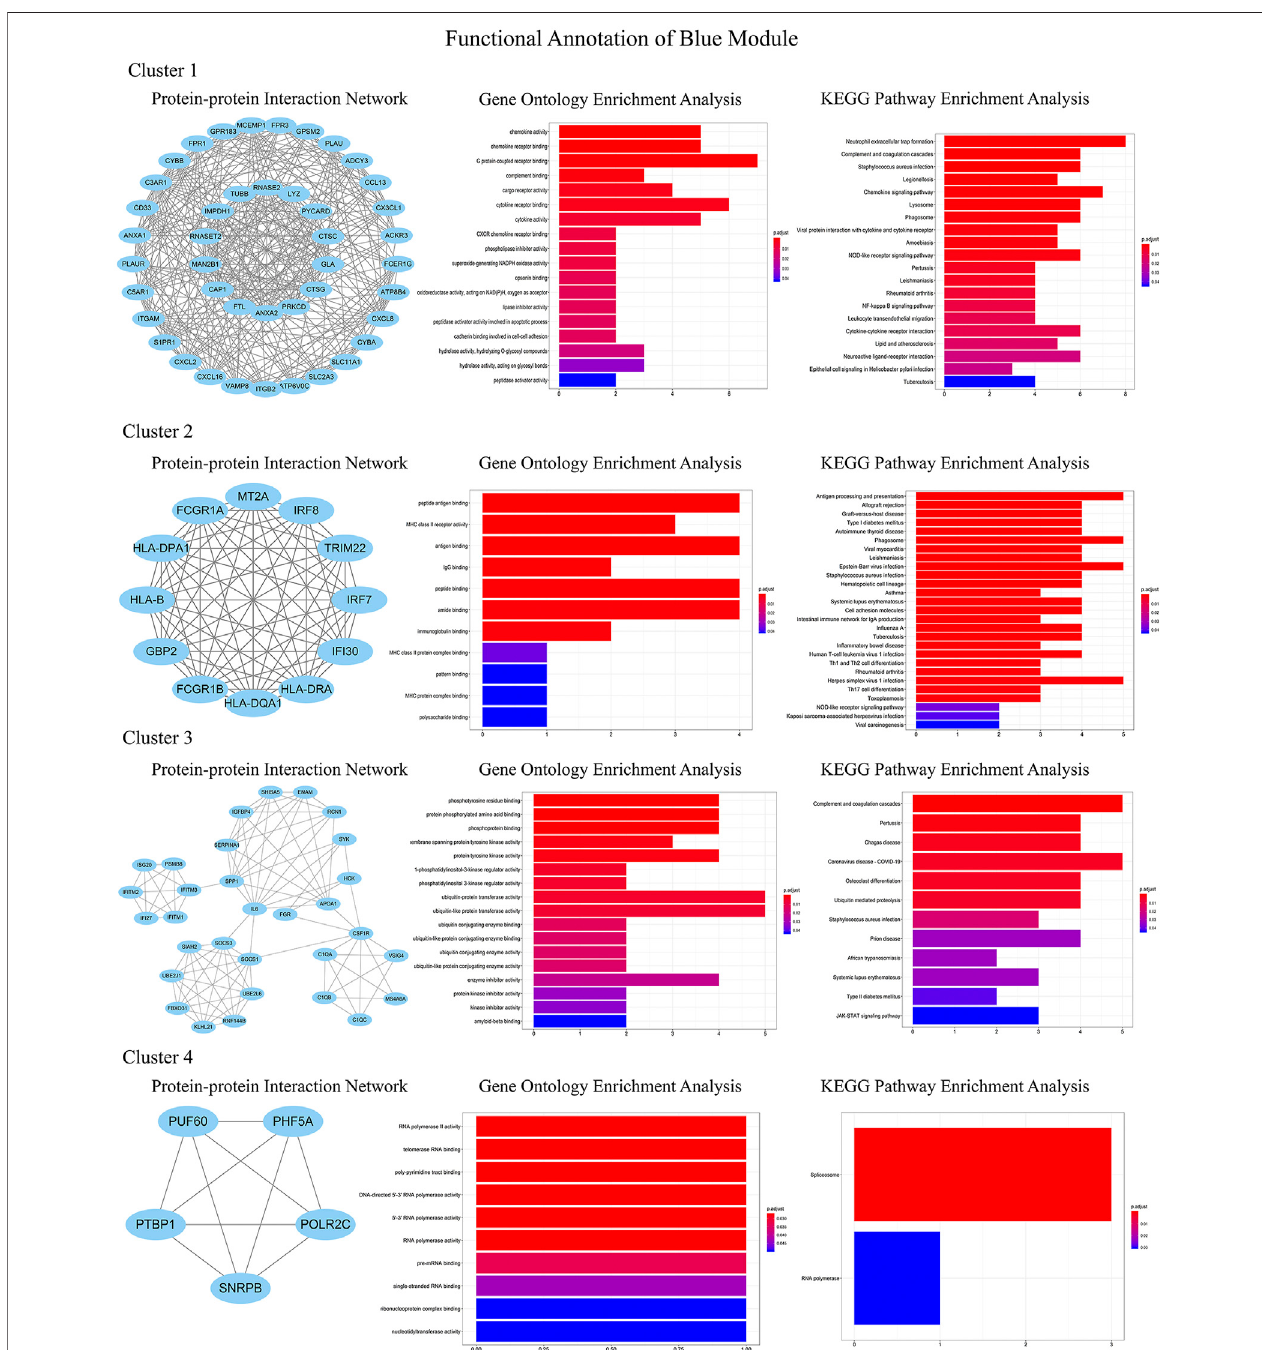
FIGURE 5 | Functional annotations of four clusters in blue module (including protein-protein interaction network, gene ontology enrichment analysis and KEGG pathway enrichment analysis). Genes in blue module were involved in cytokine chemotaxis, pathogen infection, in fl ammatory response, antigen presentation, and atherogenesis, which may be contributed to the development of HCM.